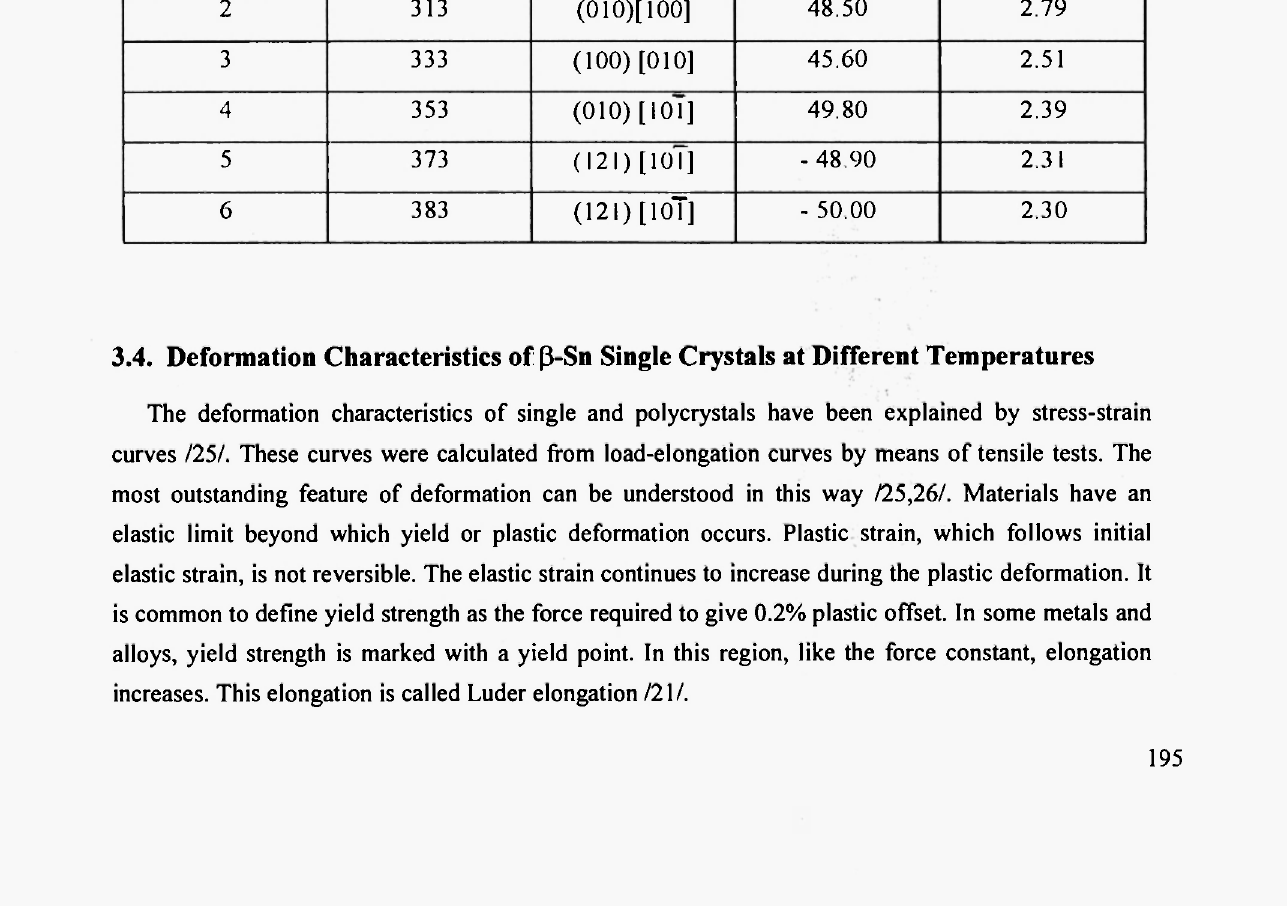
Fig. 3.3: Stress-strain curves of crystals numbered 1, 2, 3, 4, 5 and